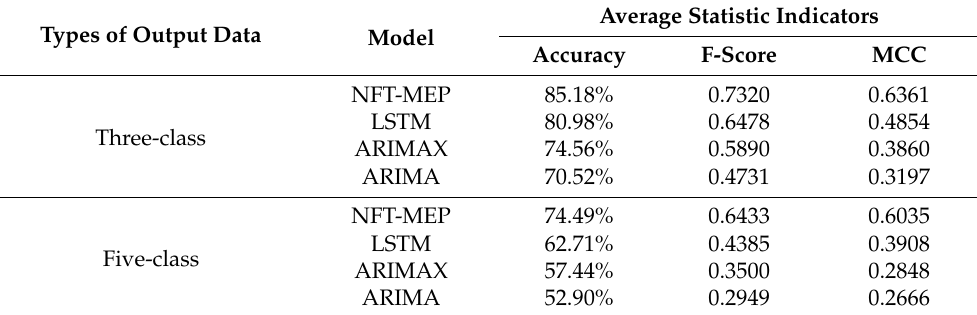
Table 6. The comparison result of four prediction models to predict hourly PM 10 with three and five classes of output data.